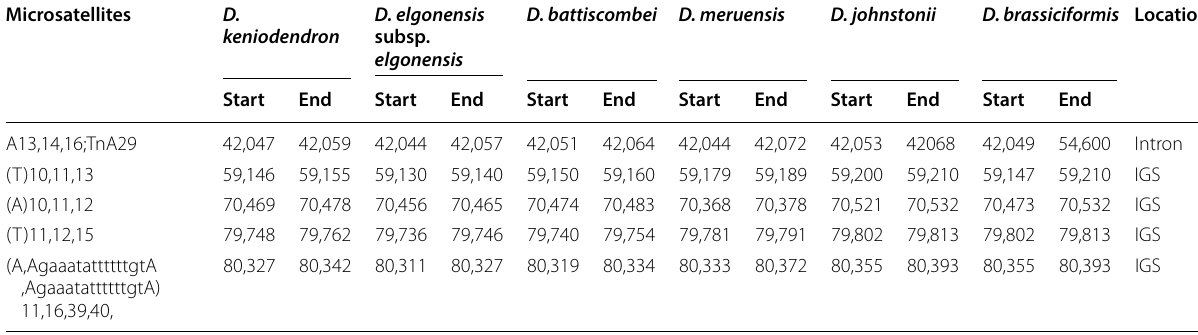
n varying number of base pairs between two repeat motifs = Table 4 Details of potentially polymorphic microsatellite repeats in six species of Dendrosenecio